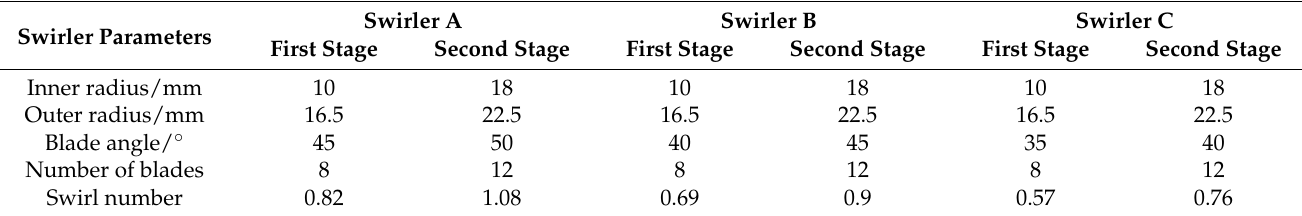
Table 1. Structural parameters of